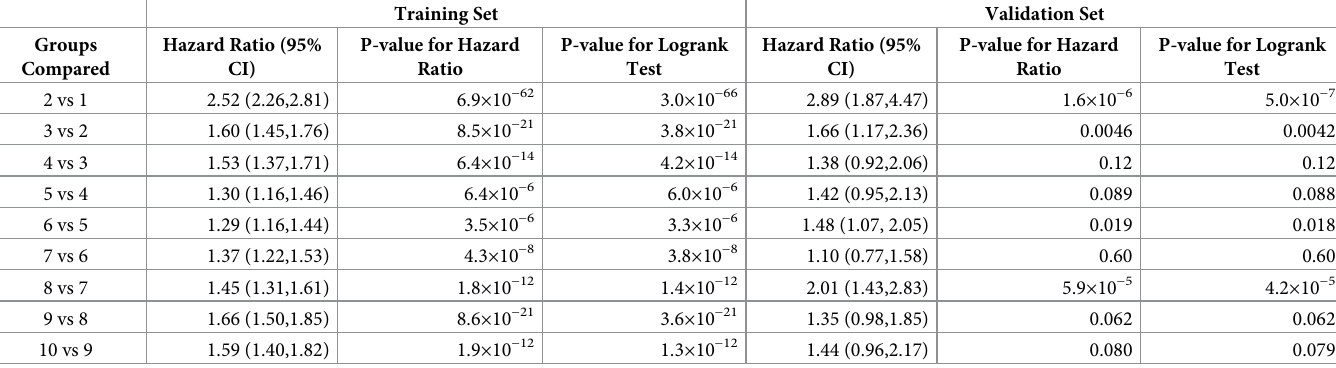
Table 2. Output of the Cox proportional hazards regression model and the logrank test for EACCD grouping on the basis of T, N, M, A, and S on the training set.